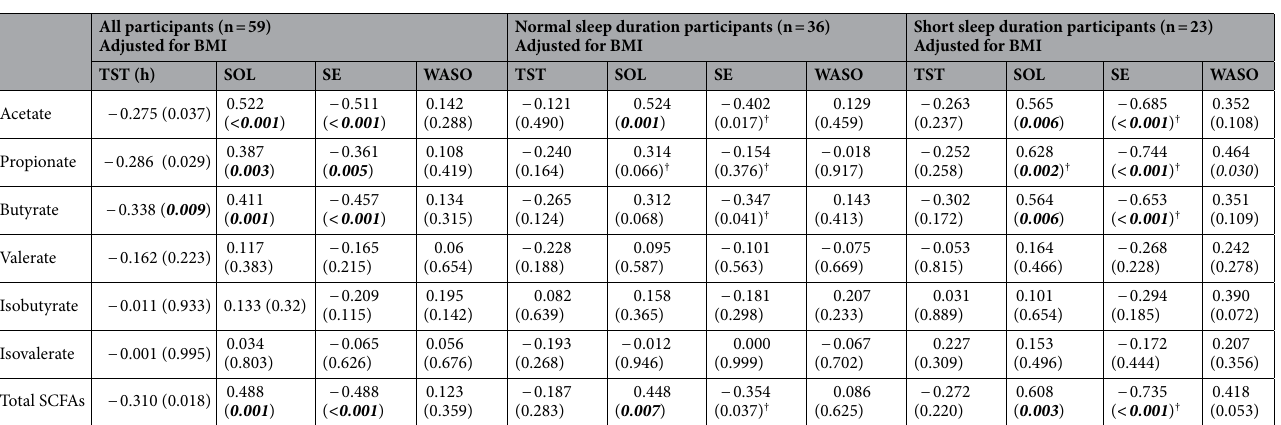
Table 2. Spearman’s partial correlation coefficients and p-values (in parentheses) between SCFA concentrations and sleep measures in the Study Population (n = 59), Normal Sleep Duration participants (n = 36), and Short Sleep Duration participants (n = 23) adjusted for the effects of BMI. Bold-italicized numbers are statistically significant results with p < 0.01 (p value in parentheses). † Correlation significantly different than counterpart group correlation p < 0.05 (one-tailed). Calculated only when at least one of the correlations compared is